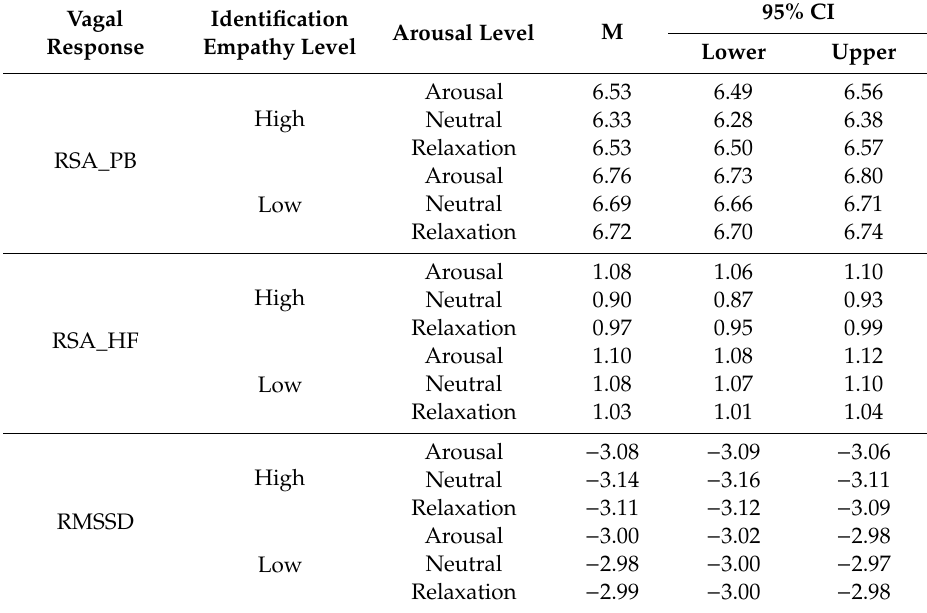
Table9. Descriptivestatisticsofvagalresponsedependingonidentificationlevelandarousal. M = Mean, SD = Standard